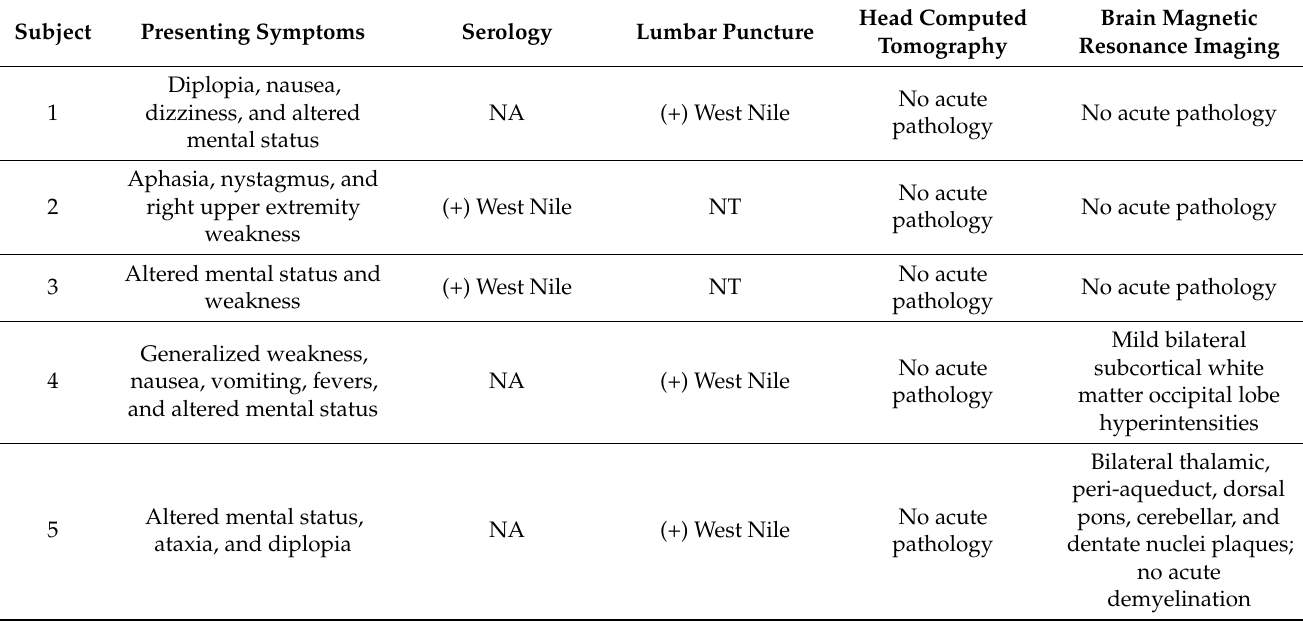
Table 3. Subject presenting symptoms, West Nile Virus testing, and imaging studies.